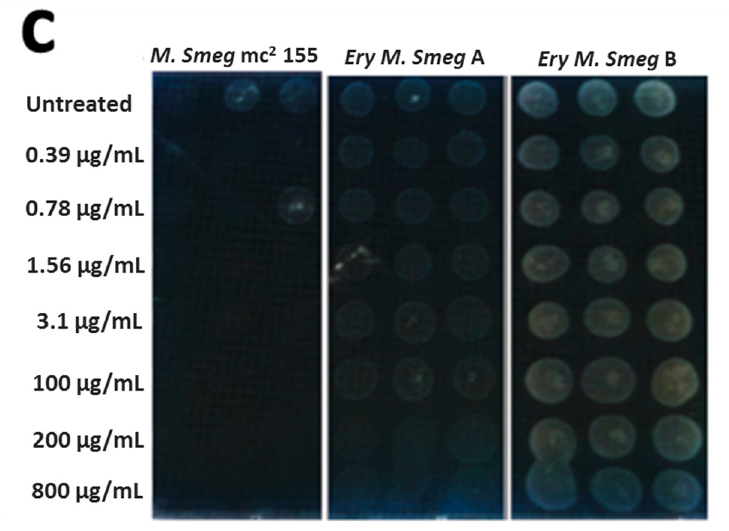
Figure 3. Viability assay of the drug-susceptible and MDR Mycobacterium smegmatis strains following exposure to low and high concentrations of erythromycin. Overnight cultures of these strains were either untreated or exposed to low (0.39 µ g/mL; 0.78 µ g/mL; 1.56 µ g/mL; 3.1 µ g/mL) or high (100 µ g/mL; 200 µ g/mL; 800 µ g/mL) concentrations of erythromycin for either 0 h ( a ), 3 h ( b ), or 6 h ( c ). An aliquot of 5 µ L of the untreated and treated cultures were spotted onto M7H10 agar plates and incubated at 30 ◦ C for 48 h. For each treatment condition, the three spots on the M7H10 agar plate represent biological replicates. Ery M. smeg A and Ery M. smeg B represent the two erythromycin-resistant clones derived from the Mycobacterium smegmatis mc 2 155 strain.